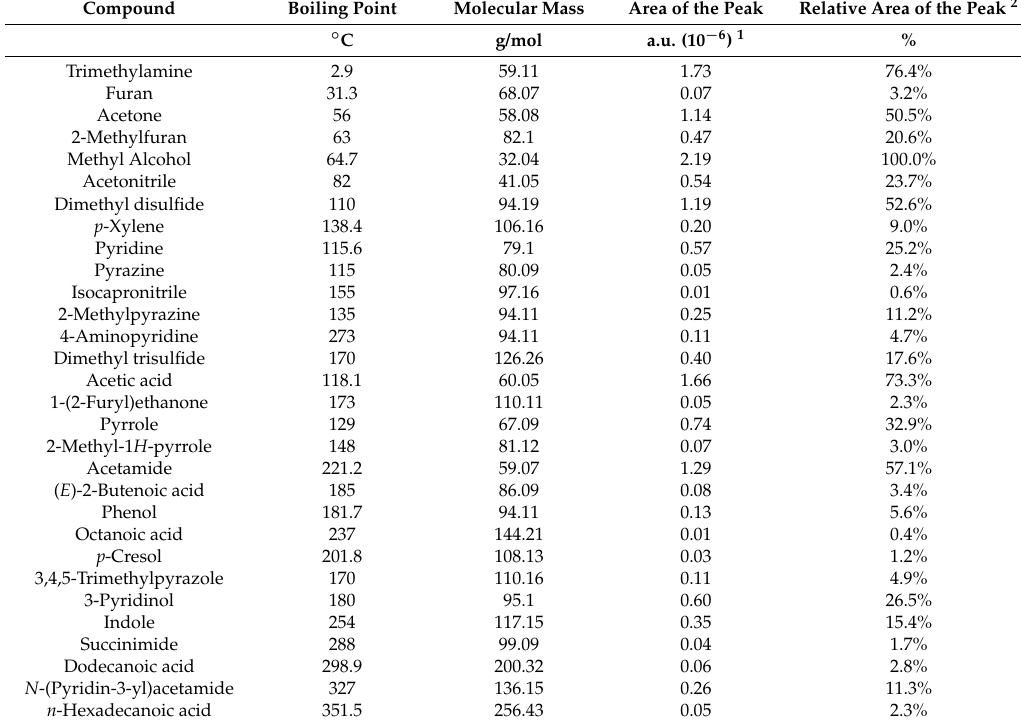
Table 6. Compounds identified in the first impinger bottle, using GC-MS